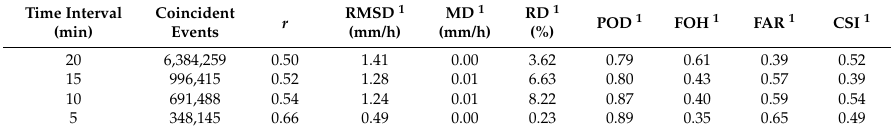
1 The metrics are calculated with TRMM PR serving as the